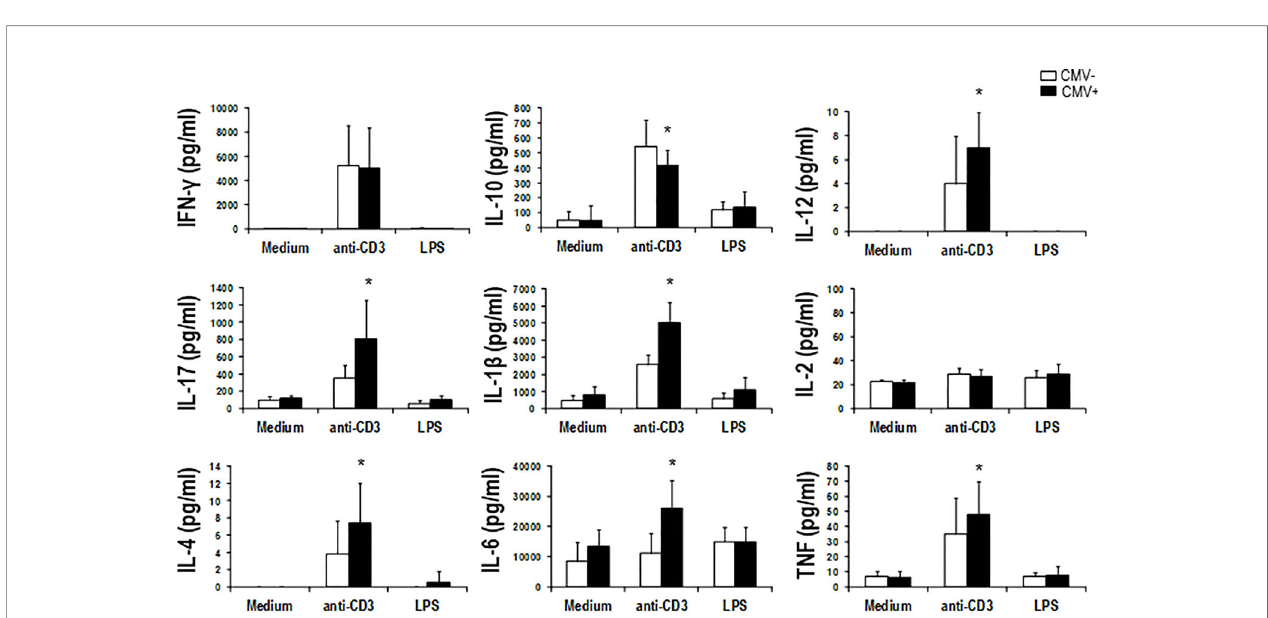
FIGURE 5 | Cytokine levels produced in response to different culture conditions in CHF patients according to their CMV-serostatus. PBMCs from CHF patients (CMV-, n = 7; CMV+, n = 9) were cultured for 5 days in medium alone, in medium containing anti-CD3 (1 µg/ml), or in medium containing LPS (1 µg/ml). In the supernatant of the different cultures, the concentrations of the different cytokines were measured using Luminex multiplex technology and analyzed according their CMV-serostatus. Bar graphs summarize the concentrations of the cytokines in the supernatants of the cultures with the different conditions studied. (means ± SEM) from the studied subjects. Paired t-test was used to compare paired means, and p-values are depicted in the panels. *indicates a signi fi cant difference (p <0.05) compared to the other groups.